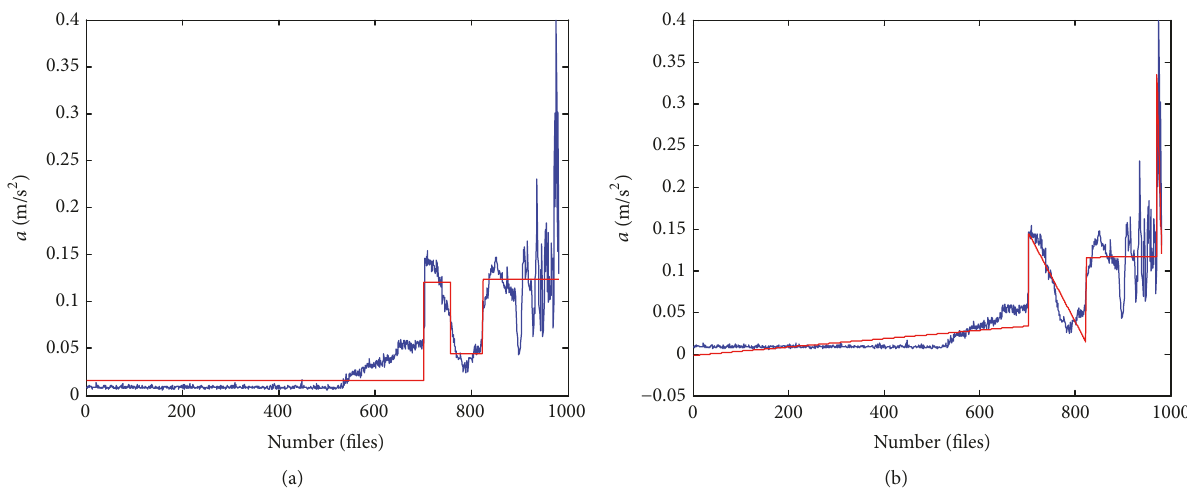
Figure 10: The optimal fourth-order segmentations of ADF by mDP algorithm. (a) Constant fitting and (b) linear fitting.